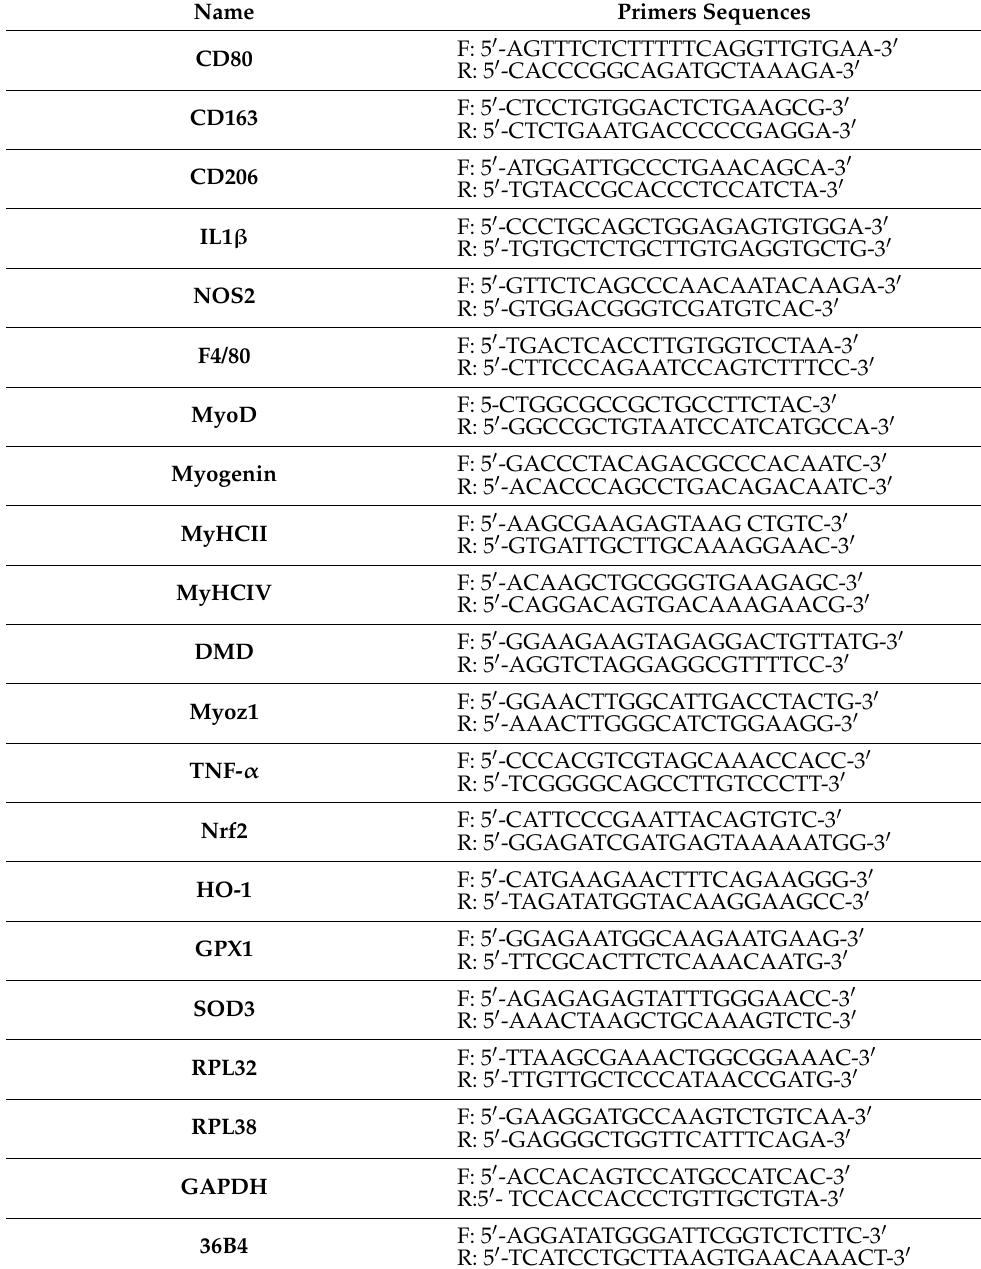
Table 1. List of primer sequences used for RT-qPCR